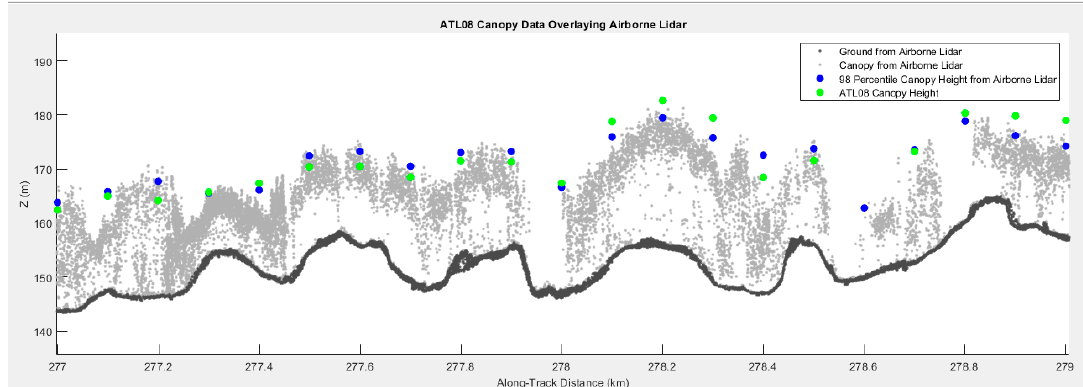
Figure 11. A subset of the ATL08 Canopy height validation results from track ATL08_20181124001516_08610105 over Finland [14,27]. The airborne lidar point cloud (truth) are shown as grey dots where the canopy and terrain points have been isolated as light and dark shades of grey. The ATL08 canopy height (green dot) and the airborne lidar canopy height (blue dot) are plotted at the 100 m step size.